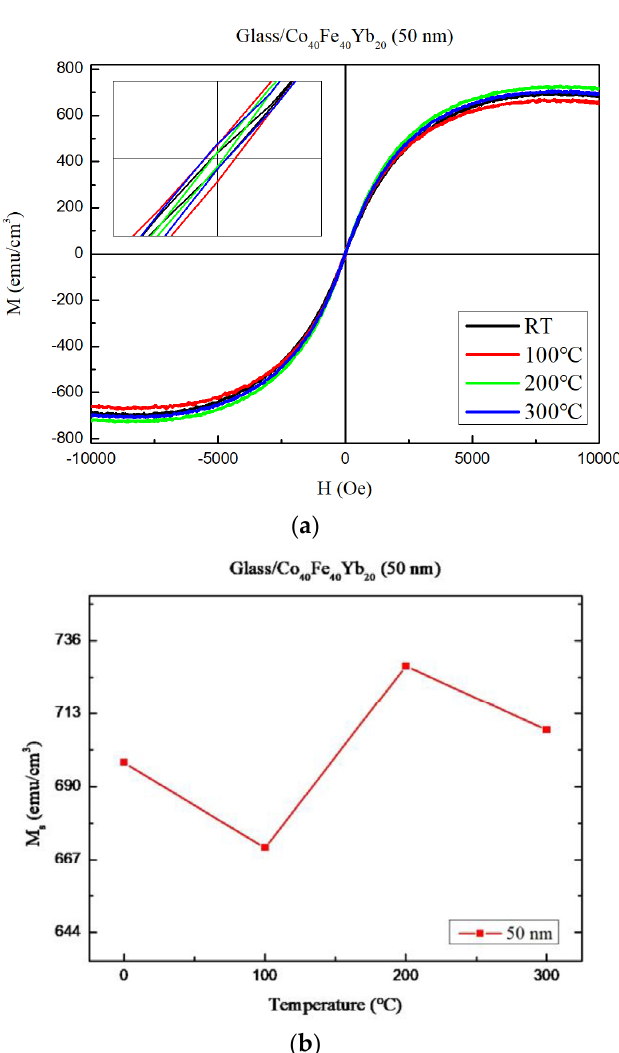
Figure 9. ( a ) In-plane magnetic hysteresis loop of Co 40 Fe 40 Yb 20 thin films at 50 nm. ( b ) Saturation magnetization (M S ) of Co 40 Fe 40 Yb 20 at 50 nm.